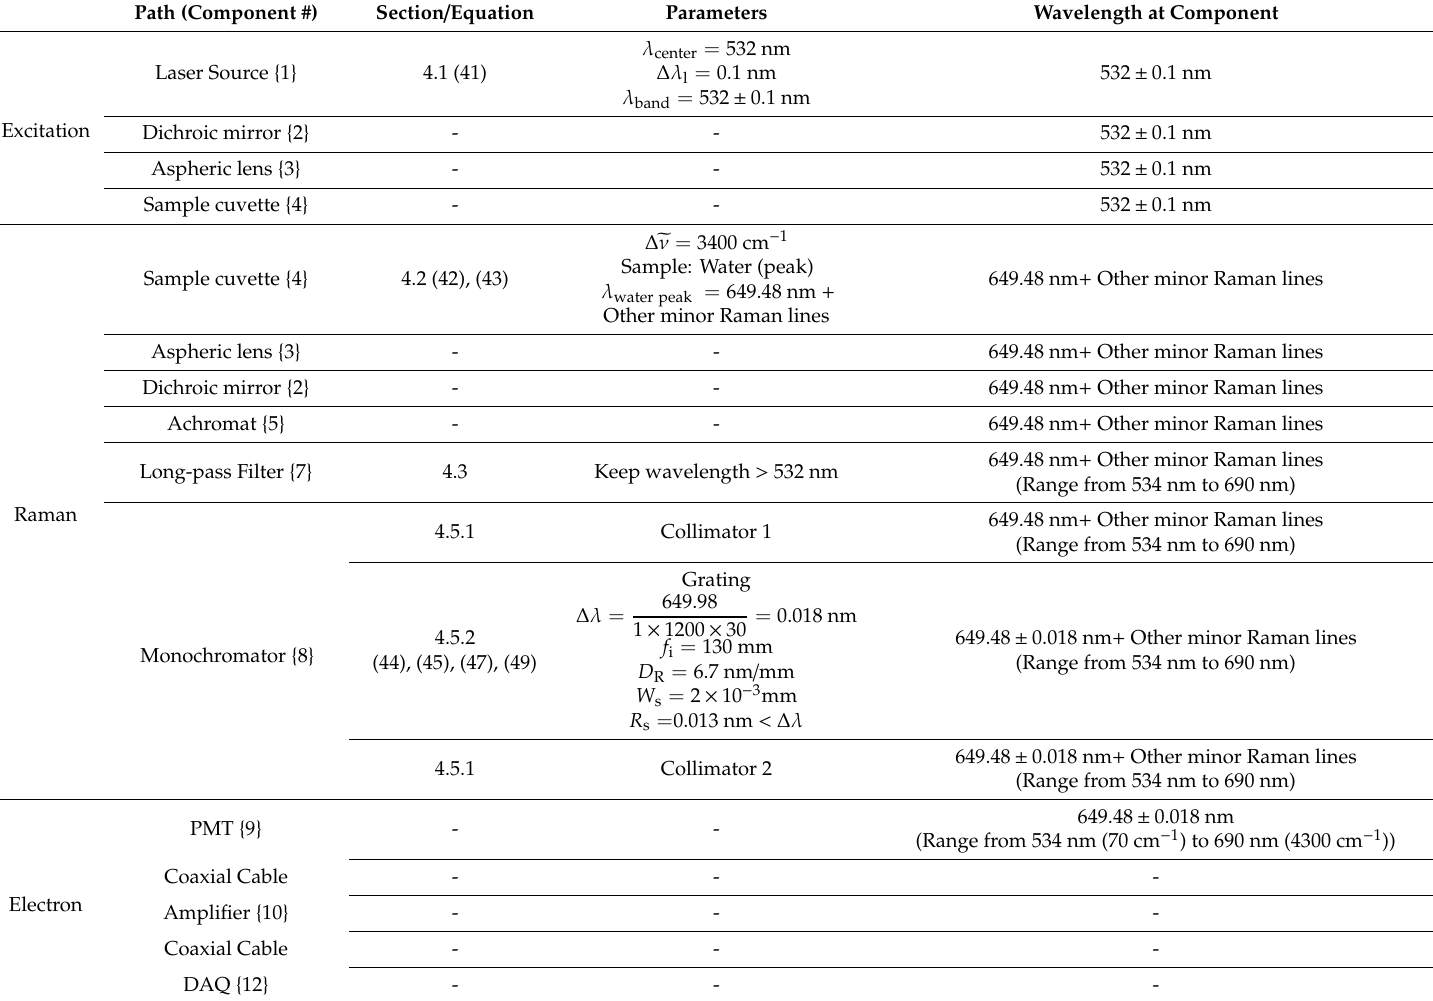
Table 8. Purdue CE Spectroscopy Lab 532 nm open-path TRRS example wavelength